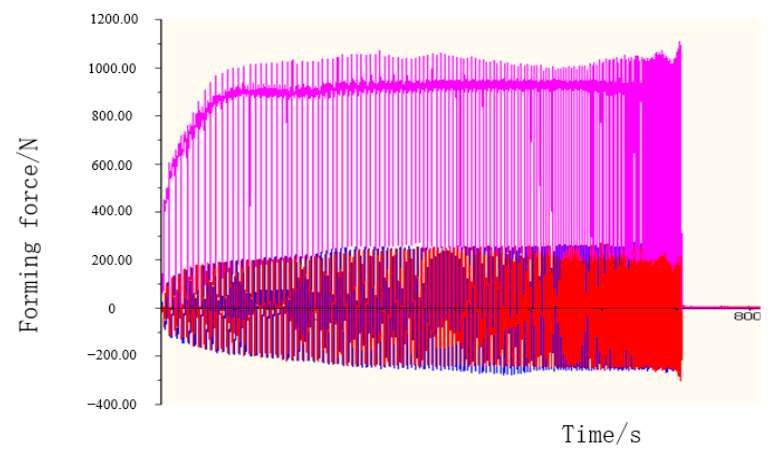
Figure 8. Deformation force measured by experiment 1.